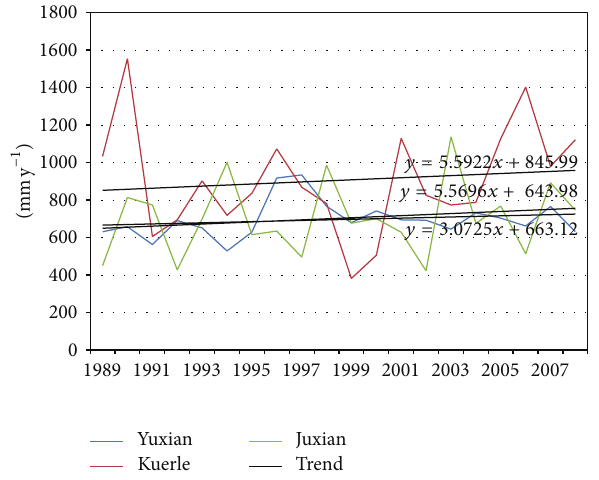
Figure 10: PET at the selected weather stations from 1989 to